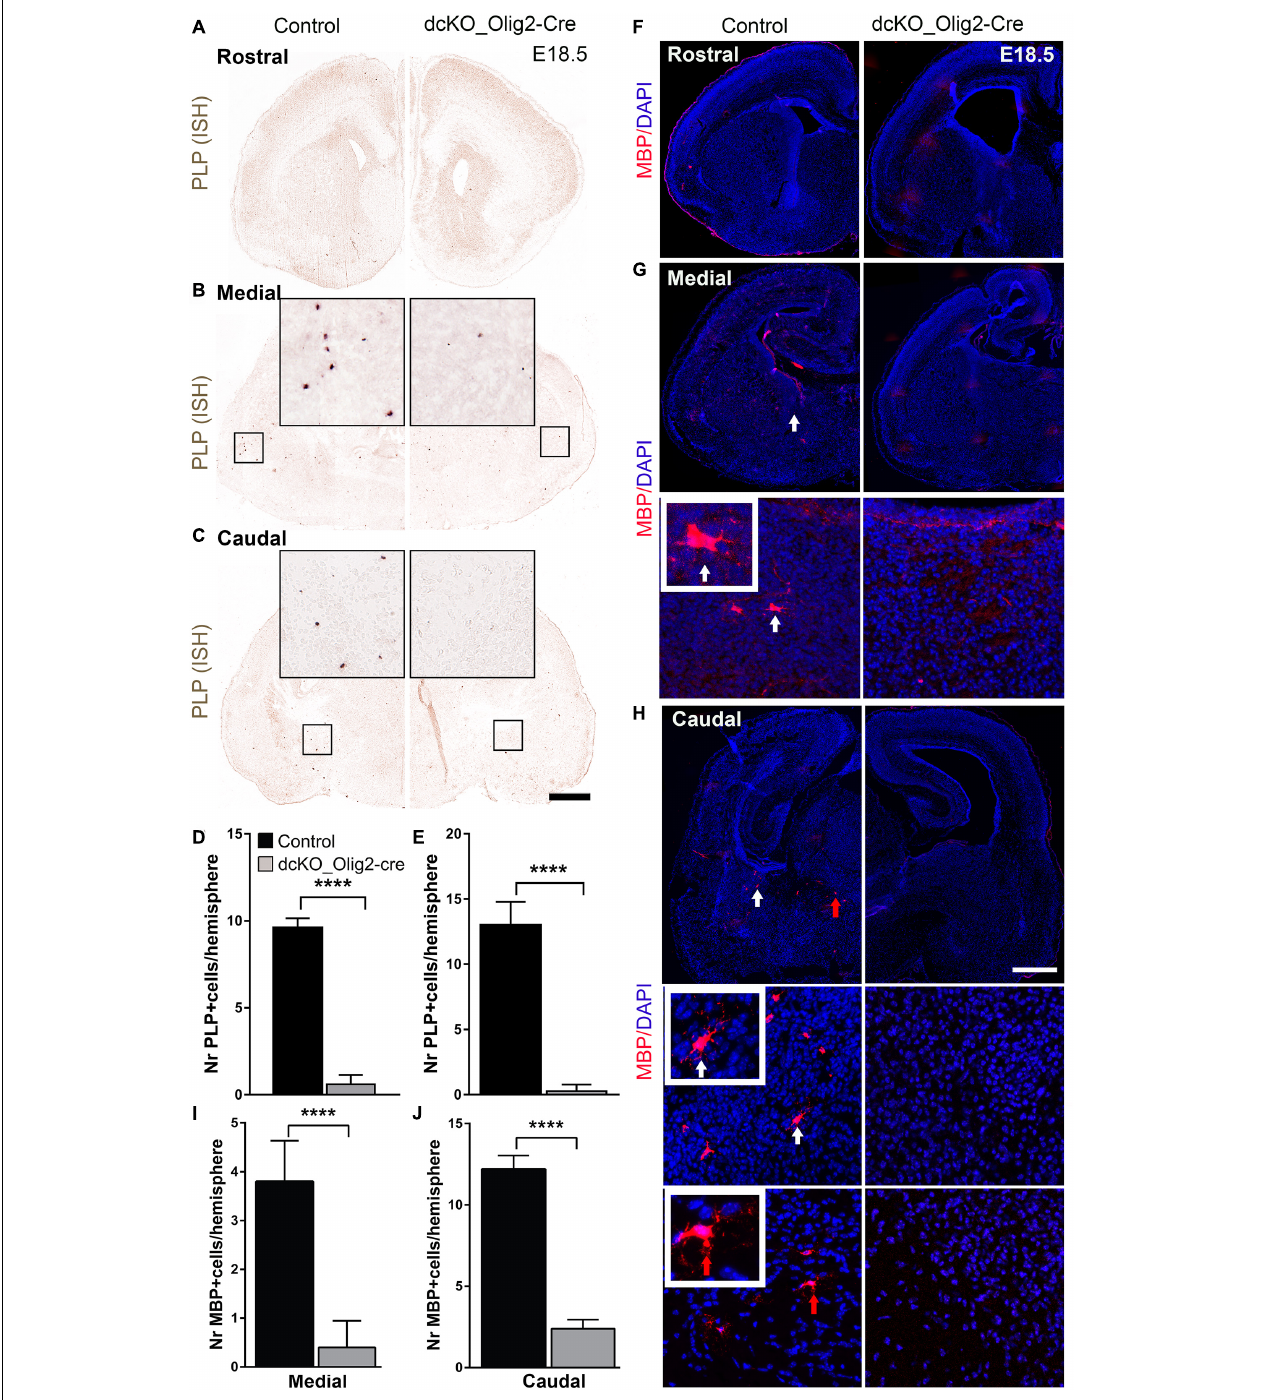
FIGURE 6 | Number of PLP + , MBP + oligodendrocytes is reduced in dcKO_Olig2-Cre mutant forebrain at E18.5. (A–C) In situ hybridization images showing the E18.5 control and dcKO_Olig2-Cre forebrain coronal sections with riboprobed for PLP expression. (D,E) Bar charts showing quantification of PLP-expressing cells in the E18.5 control and dcKO_Olig2-Cre at the middle (D) , and caudal (E) levels of the ventral telencephalon Experimental replicates ( n ) = 5, Scale bars = 100 µ m. (F–H) Micrographs showing the rostral, middle, and caudal sections of the E18.5 mouse forebrain immunostained with MBP and with DAPI counterstaining. Inserted images are higher magnification of MBP-expressing cells indicate by white and red solid arrows. (I,J) Bar graph showing significantly diminished number of cells expression MBP in the E18.5 control striatum compared with that of dcKO_Olig2-Cre. Note that PLP + , MBP + cells are very rare in E18.5 control and dcKO_Olig2-Cre forebrain at rostral level and are not included in statistical analysis. Data are presented as means ± SEMs; **** p ≤ 0.0001); Experimental replicates ( n ) = 6. Scale bars = 100 µ m.